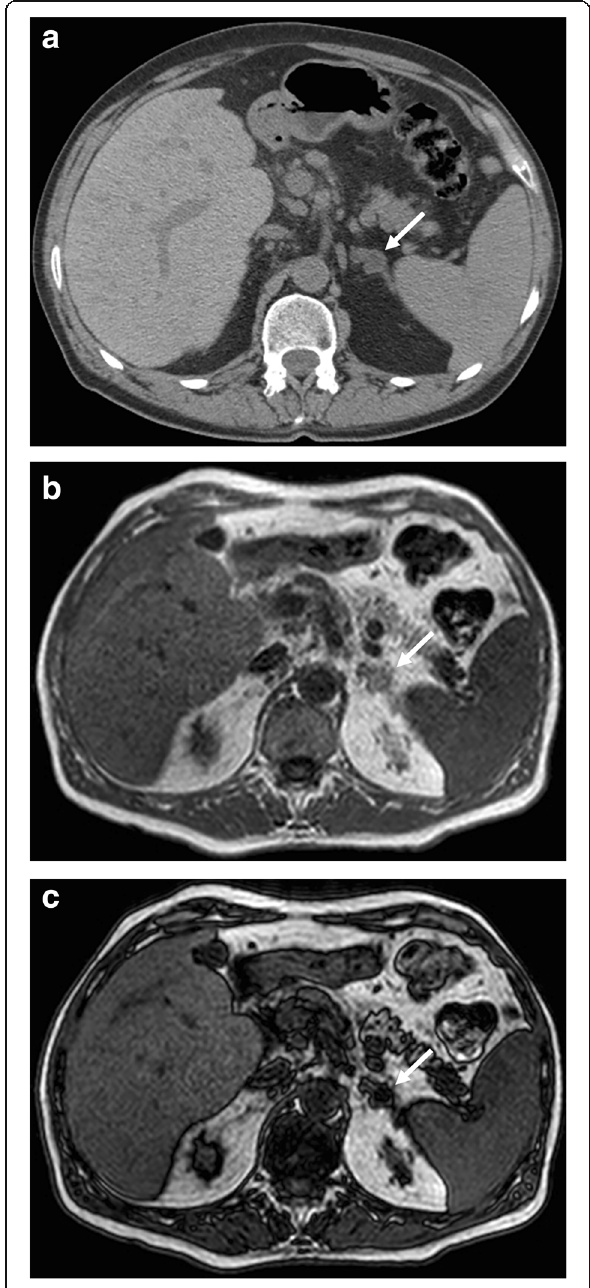
Fig. 1 Adrenal adenoma of a 45-year-old woman. Unenhanced CT ( a ) shows a left adrenal mass (arrow) with lower attenuation values than 10 HU. Axial T1-weighted in-phase ( b ) and out-of-phase ( c ) gradient recalled echo MR images show prominent loss of signal on